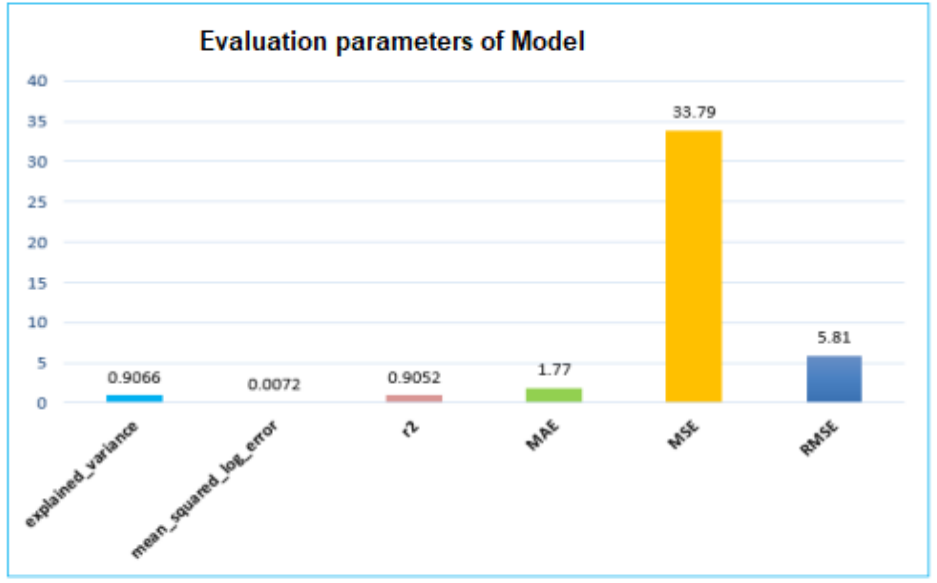
Figure 13. Random Forest Regressor Parameters.